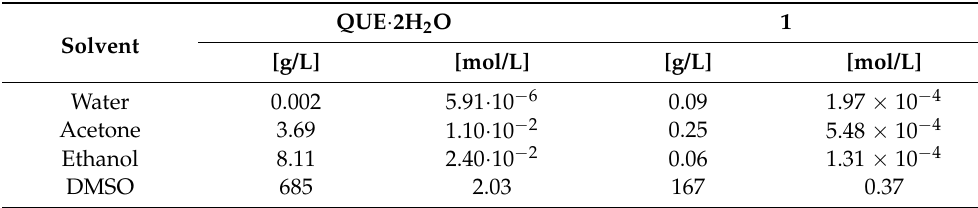
Table 5. The solubility of QUE · 2H 2 O and 1 at 20 ◦